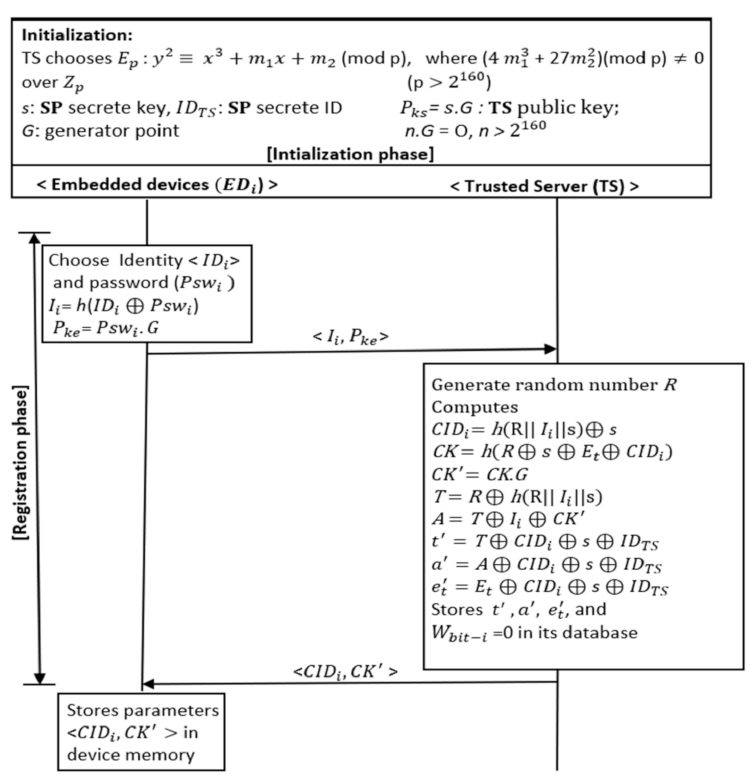
Figure 1. Proposed elliptic-curve cryptography (ECC)-based registration